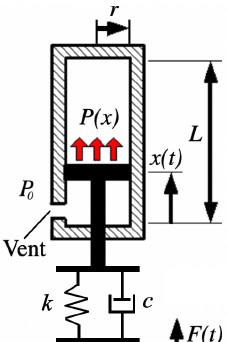
Figure 4. Diagram of pneumatic (air) spring for a simple cylinder, with radius r , length L , displacement x ( t ) , initial (atmospheric) pressure P 0 and gauge pressure P ( x ) , on top of a mechanical spring with stiffness k and damping c . The whole system is subjected to external force F ( t ) , which responds as a spring restoring force F s ( t )